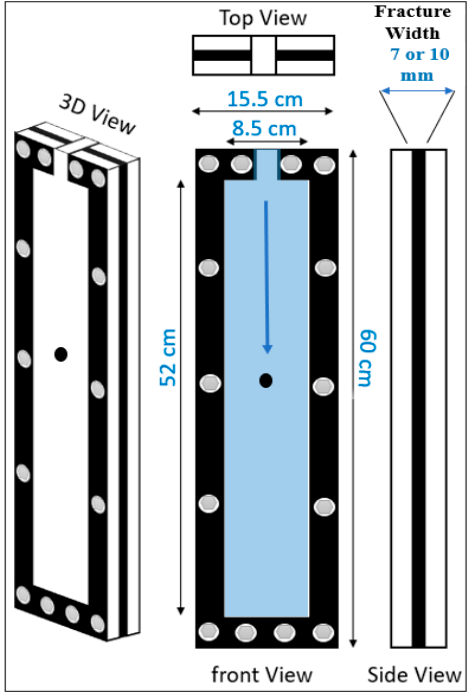
Figure 2. Confined fracture fluid system.